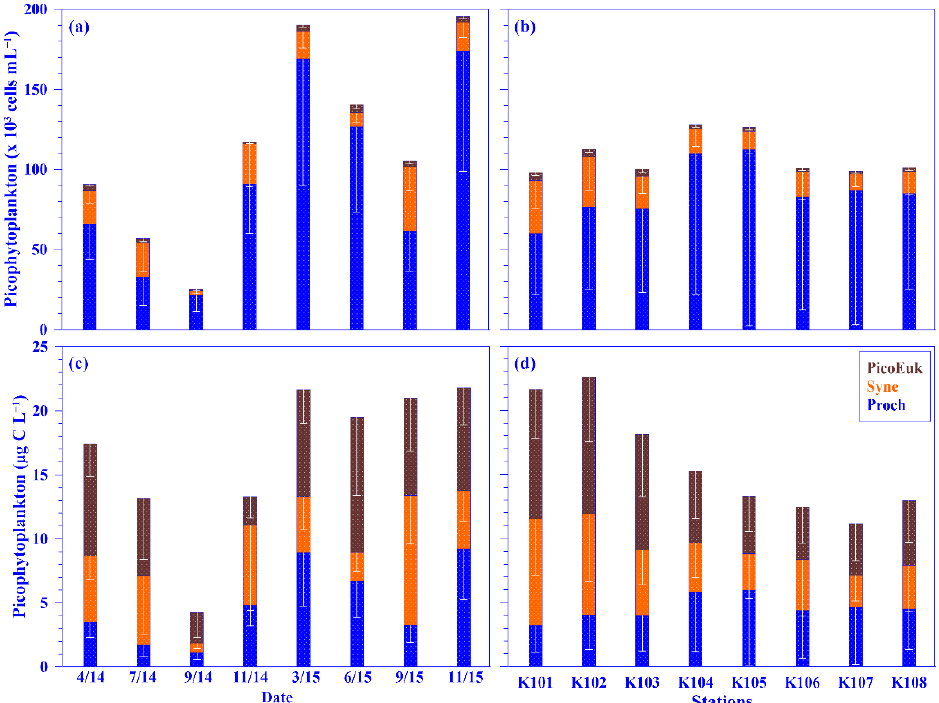
Figure 7. Temporal and spatial variations of the mean values of picophytoplankton (i.e., Prochloro- coccus [Proch] + Synechococcus [Syne] + picoeukaryotes [PicoEuk]) in terms of abundance ( a , b ) and biomass ( c , d ) across the KTV1 transect of the Kuroshio. The depth-normalized integrated value over 100 m water column of each variable at each sampling station was used for the mean values. The mean values were averaged across all stations of the KTV1 transect for each sampling period or across each station of the KTV1 transect for all the sampling periods. The standard deviations are illustrated as vertical white lines with caps.